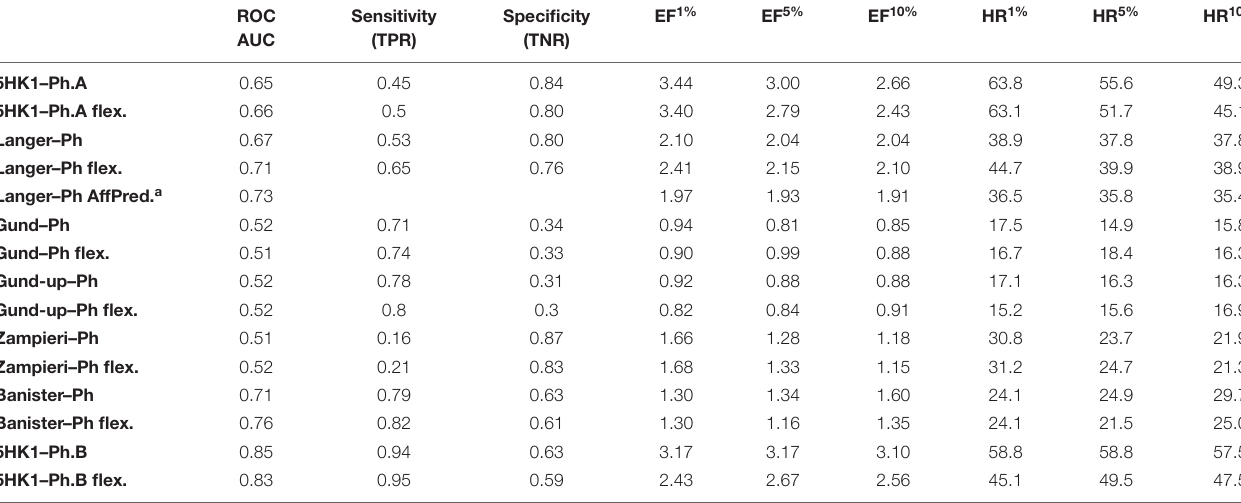
( Figure 9 ) and used to screen the same 3D multiconformational database applying again both rigid and flexible fit. The new results and statistical measures can be found as well in Table 2 and Figure 8 . We found that by merging the two HYD features sensitivity increased to optimal values (around 0.95), which means that 5HK1–Ph.B is able to recognize almost